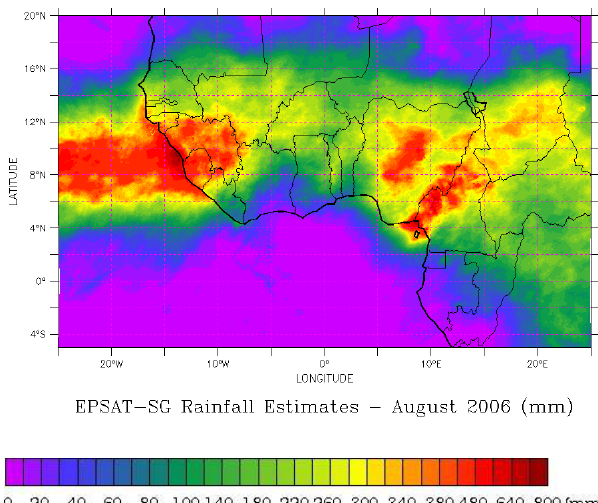
Figure 13.c. Daily cumulated EPSAT-SG on a 1° grid. Fig. 13c. Daily cumulated EPSAT-SG on a 1 ◦ grid.